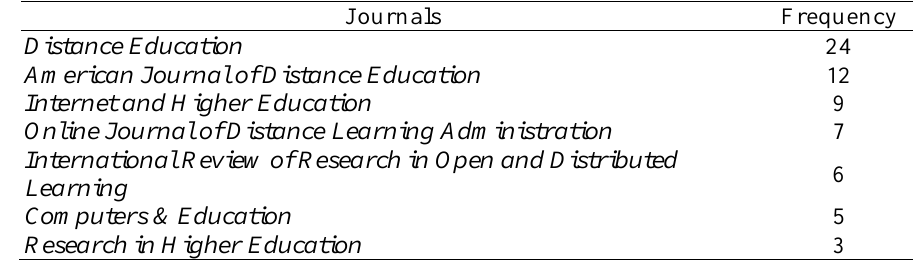
Distribution of Journals with Three or More Papers in This Study